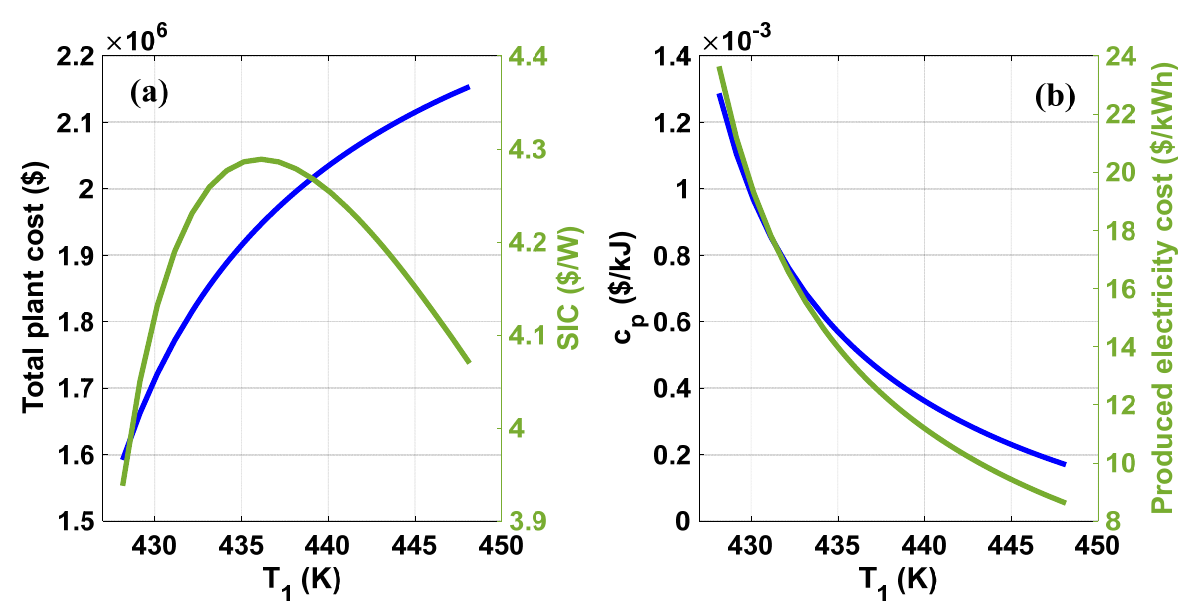
Figure 6. ( a ) The total plant cost and specific investment cost variations with the inlet temperature of production well. ( b ) Production and produced electricity cost rate variations against the production well inlet temperature.